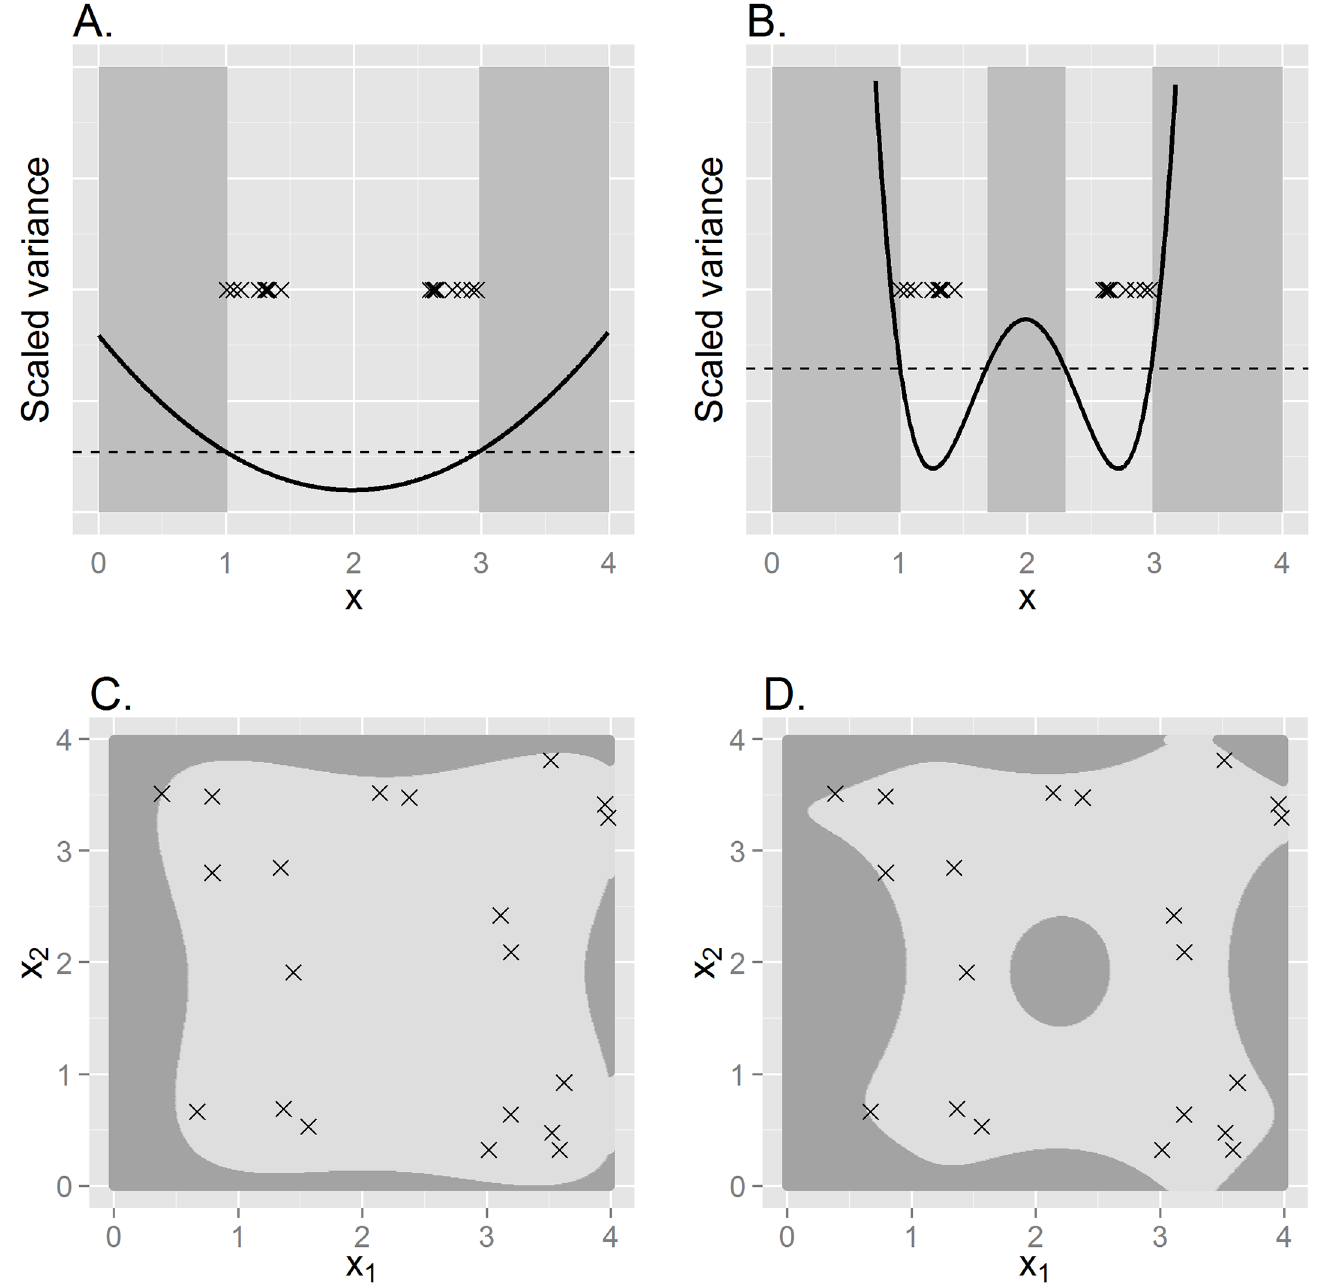
Fig 1. Example IVHs constructed from simulated data. In (A) and (B), linear regression is used to relate a response variable to a single covariate, x , obtained at locations denoted with an “ x ” . Using x as a simple linear effect (A), only predictions less than the minimum observed value of x or greater than the maximum value of x are outside the IVH (shaded area), as scaled prediction variance in these areas (solid line) is greater than the maximum scaled prediction variance for observed data (dashed line). Using both linear and quadratic effects (B), some intermediate points are also outside the IVH. When both linear and quadratic effects of two covariates ( x 1 and x 2 ) are modeled, the IVH is more nuanced and depends on whether interactions are omitted (C) or included (D).